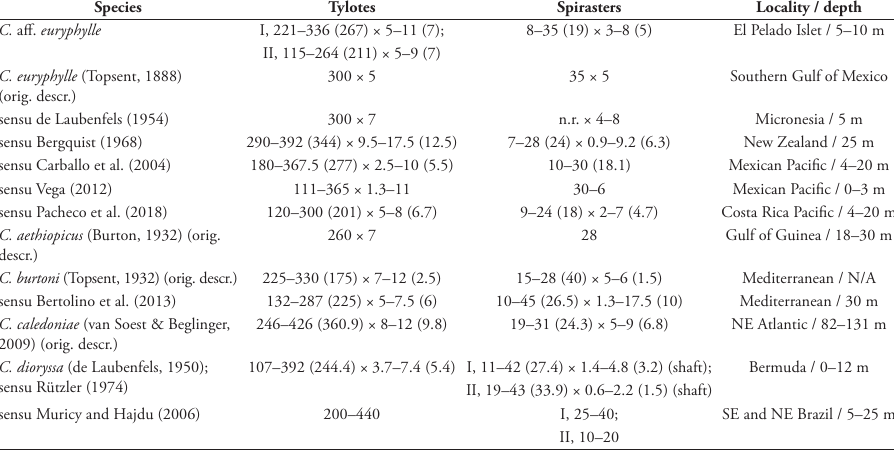
table 2. Cliona euryphylle Topsent 1888 and Cliona aff. euryphylle : Morphology of spicules, locality and depth for specimens studied here, and from the literature. Species deemed more closely related are in- cluded for comparison. Spicule morphometrics are in micrometres as range with the mean in parentheses, n.r. is not